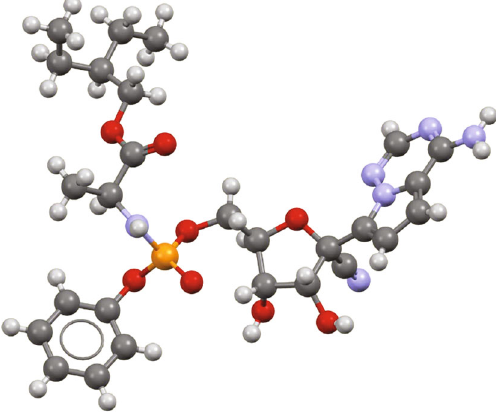
Figure 1: Molecular structure of remdesivir